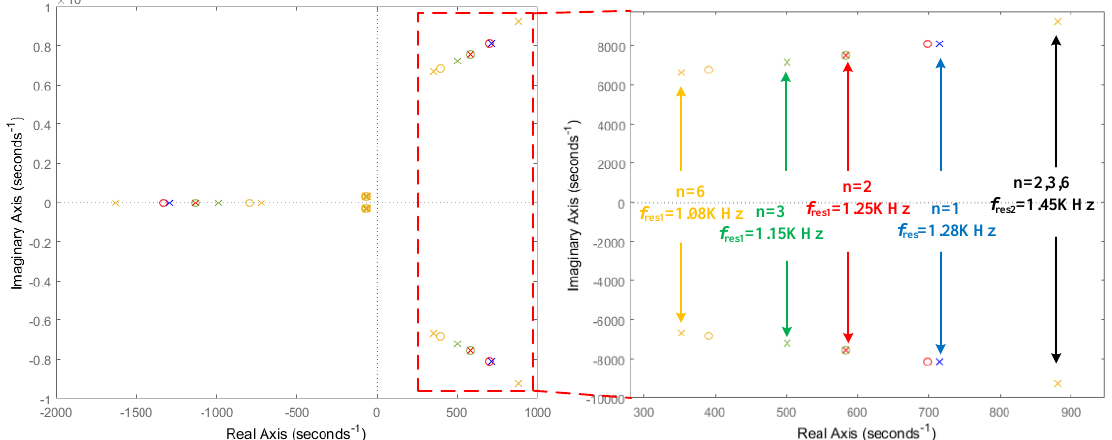
Figure 7. Zero pole diagram of single HCGI and multi-parallel HCGIs system.